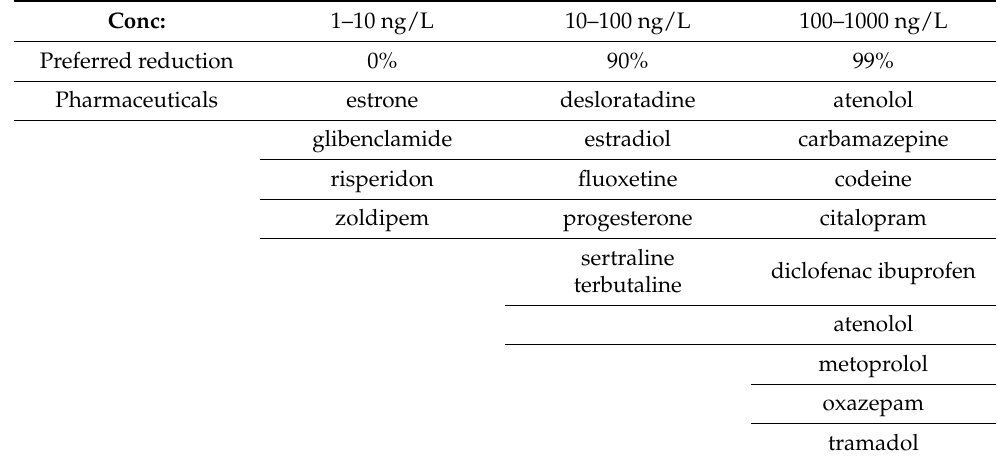
Table 3. Pharmaceuticals divided into groups based on their concentrations in Swedish wastewater effluents [4], and the desired level of reduction for each group to reach the target concentration. Conc: 1–10 ng/L 10–100 ng/L 100–1000 ng/L Preferred reduction 0% 90% 99% Pharmaceuticals estrone desloratadine atenolol glibenclamide estradiol carbamazepine risperidon fluoxetine codeine zoldipem progesterone citalopram sertraline diclofenac ibuprofen terbutaline atenolol